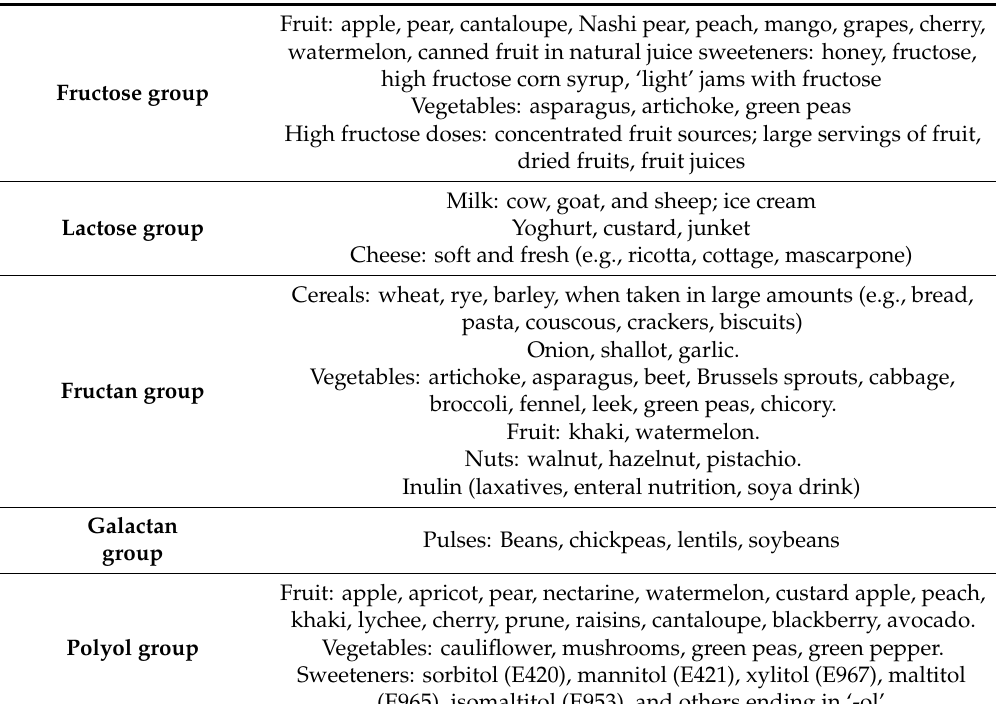
Table 2. Food with high fermentable oligosaccharides, disaccharides, monosaccharides, and polyol (FODMAP) content divided by groups (reintroduction phase). Adapted from reference [22].